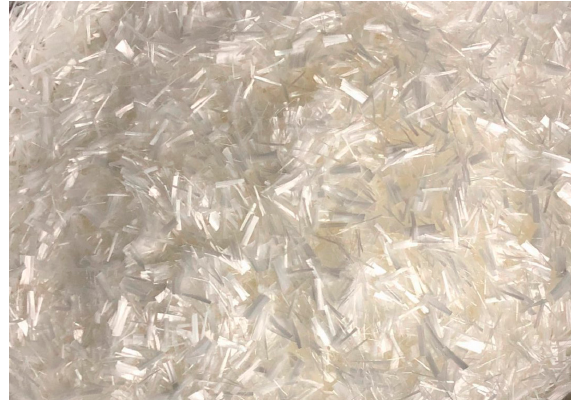
Figure 13. PVA fibers.